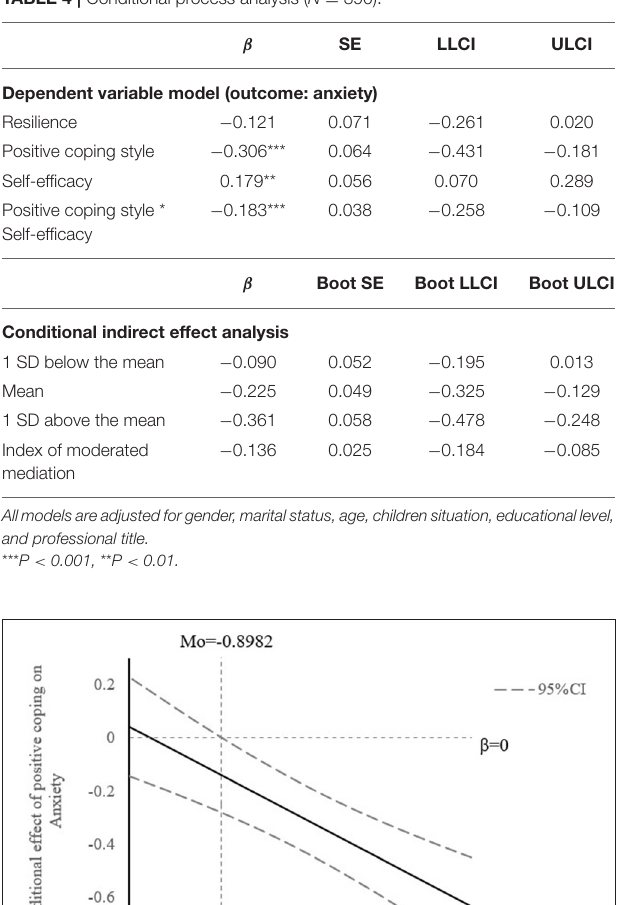
TABLE 4 | Conditional process analysis ( N = 390).